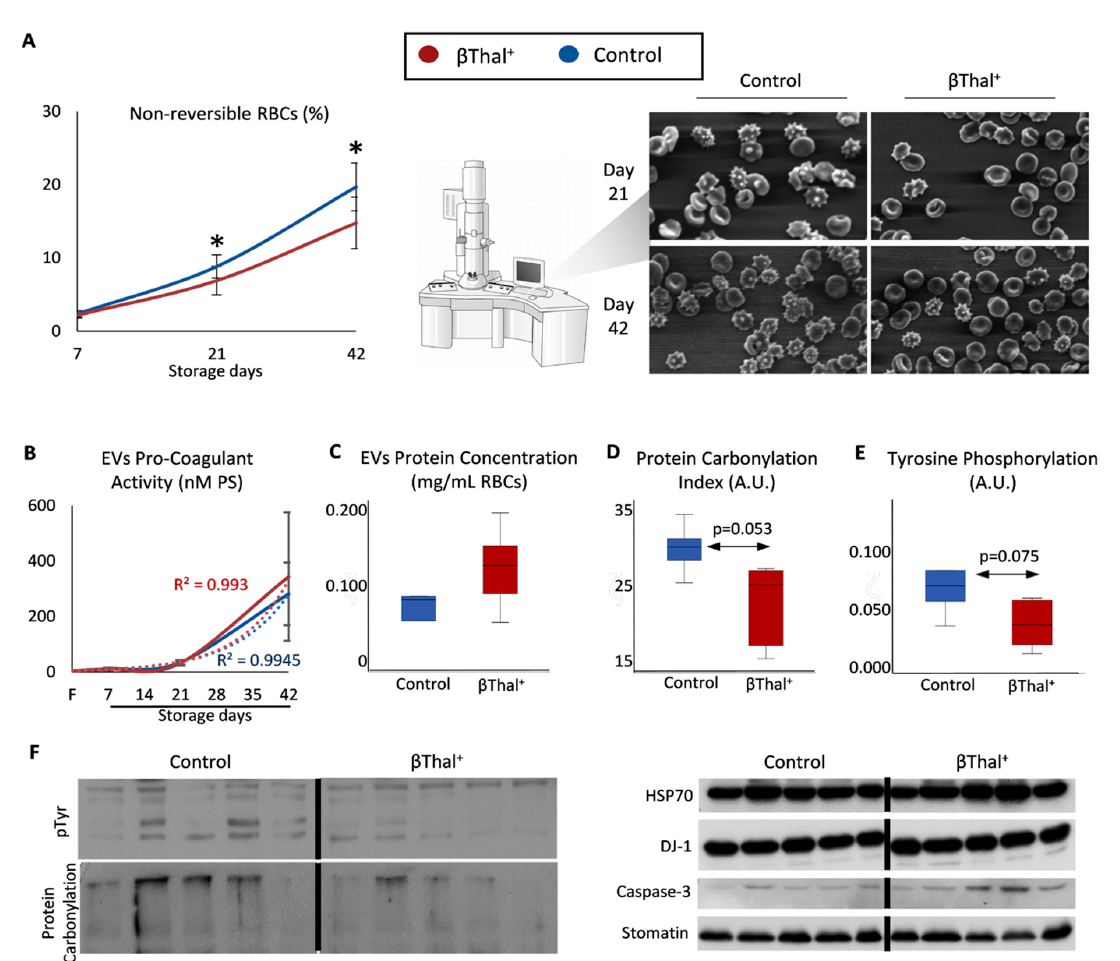
Figure 8. β Thal + RBC shape modifications and storage EV characteristics. ( A ) Percentage of non-reversible shape modifications in β Thal + and control RBC units throughout storage and representative micrographs captured by scanning electron microscopy ( n = 8 per group; magnification: 1000×). ( B – F ) EV analysis ( n = 5 per group, except procoagulant activity: n = 8 per group): procoagulant activity ( B ), total protein concentration ( C ), protein carbonylation ( D ), and protein tyrosine phosphorylation ( E ) levels in β Thal + and control EVs. ( F ) Representative immunoblots of individual proteins or protein modifications showing a trend for different expression levels in β Thal + vs. control EVs. Stomatin was used as the internal loading control. (*) p < 0.05 β Thal + vs. controls; F: fresh